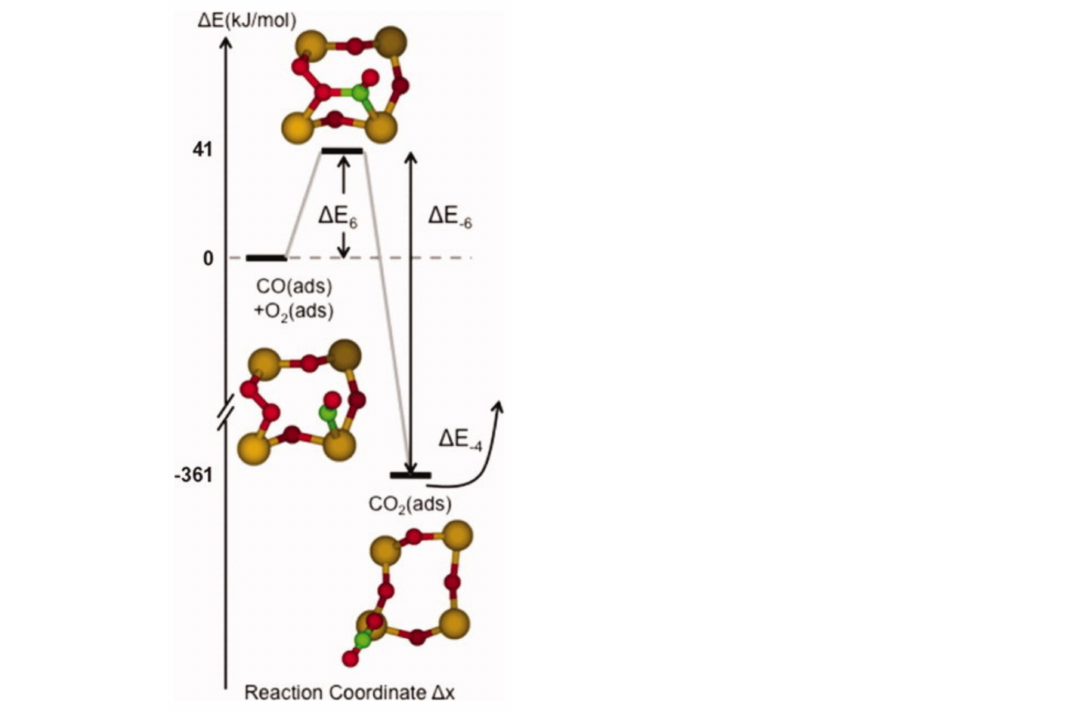
Figure 6. Coadsorption of CO and O 2 onto a reduced (101) surface of SnO 2 . CO reacts with O 2 preadsorbed onto a V O . Reproduced with permission from reference